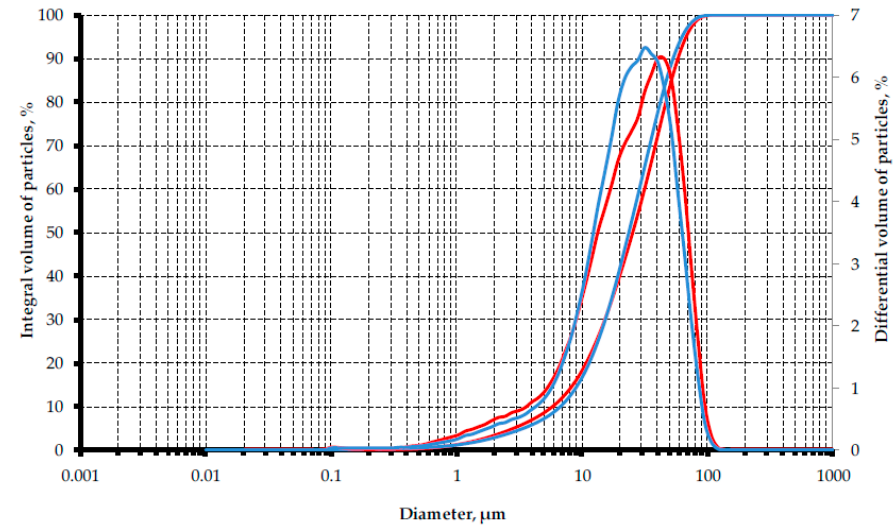
Figure 4. Granulometry of CGB ( ― ) and FGB ( ― ).